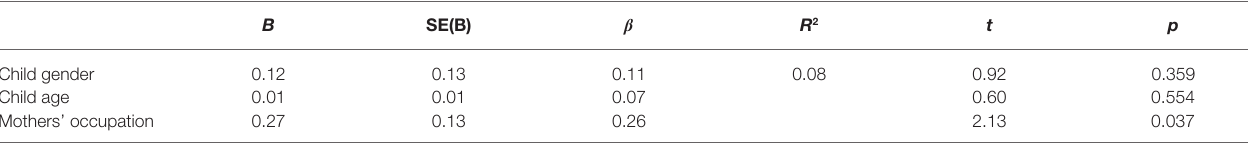
TABLE 3 | Linear regression for the effects of mothers’ occupation on childcare center children’s communal orientation while controlling for child gender and age. B SE(B) β R 2 t p Child